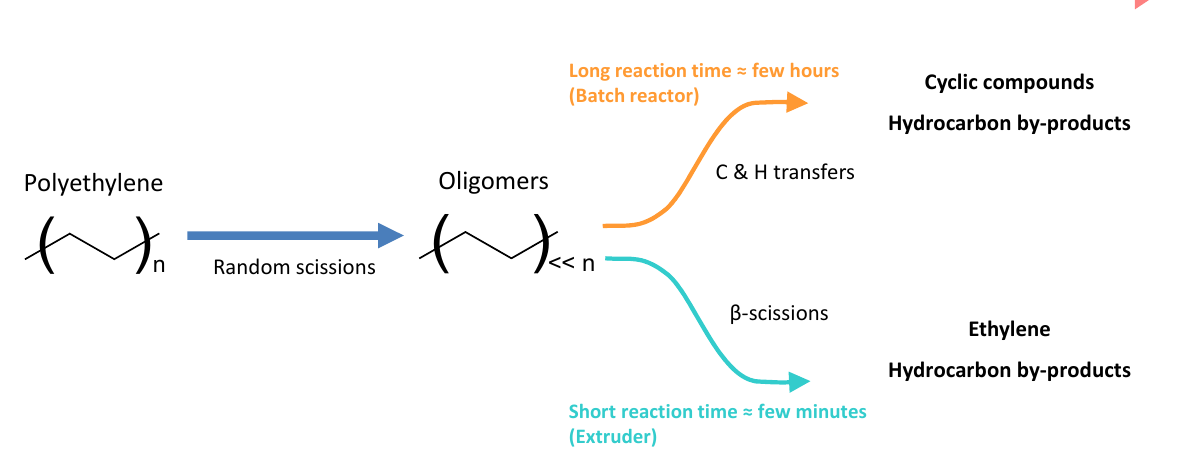
Figure 2. Representation of the different products of polyethylene degradation depending on temperature and residence time, inspired from Vollmer et al. [25].